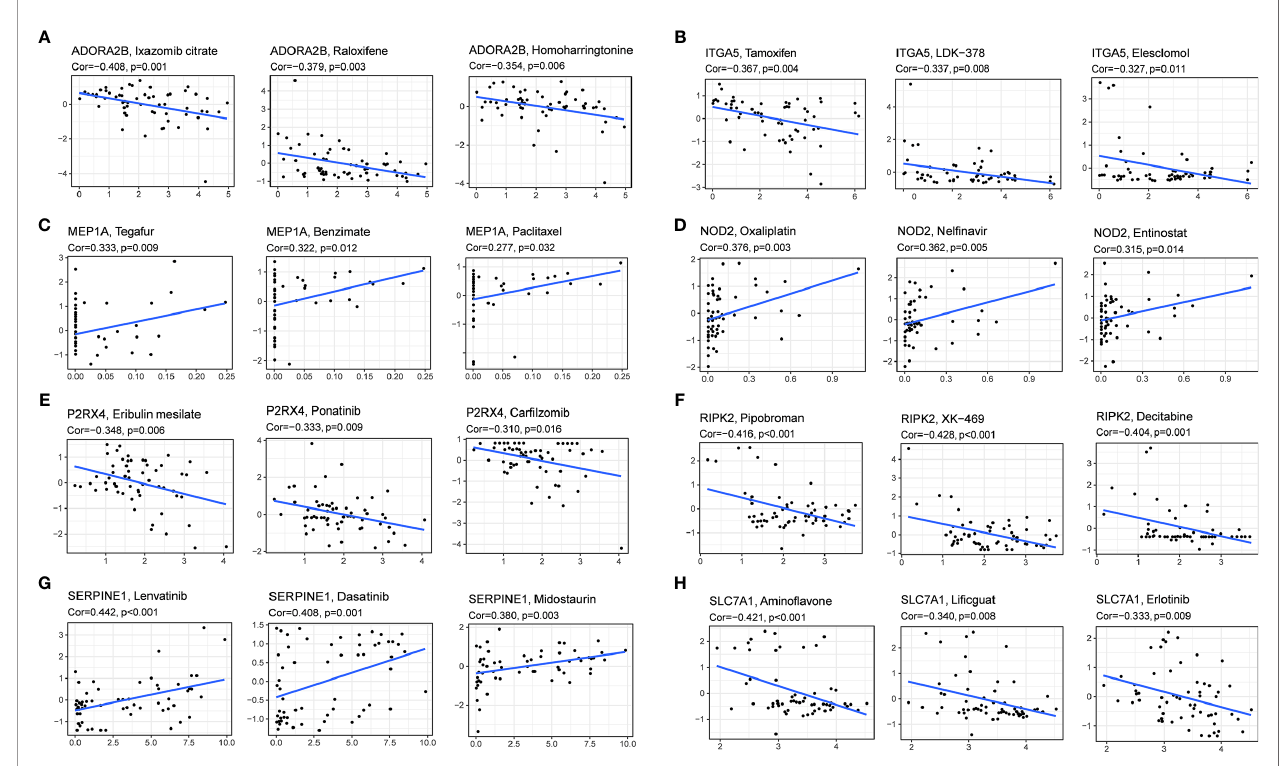
FIGURE 9 | Scatter plot of relationship between prognostic gene expression and drug sensitivity. (A) ADORA2B. (B) ITGA5. (C) MEP1A. (D) NOD2. (E) P2RX4. (F) RIPK2. (G) SERPINE1. (H)